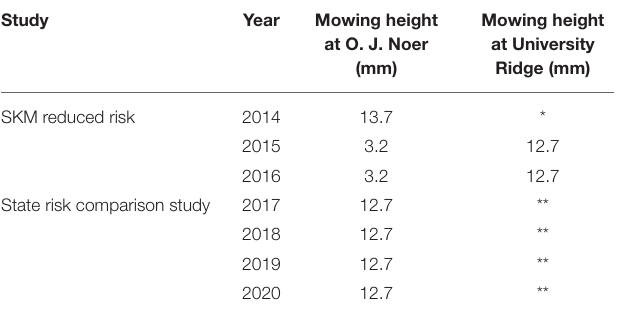
TABLE 1 | Mowing height during each year at both the O. J. Noer Turfgrass Research Facility and University Ridge Golf course for the Smith-Kerns Model (SKM) reduced risk study and the state risk comparison